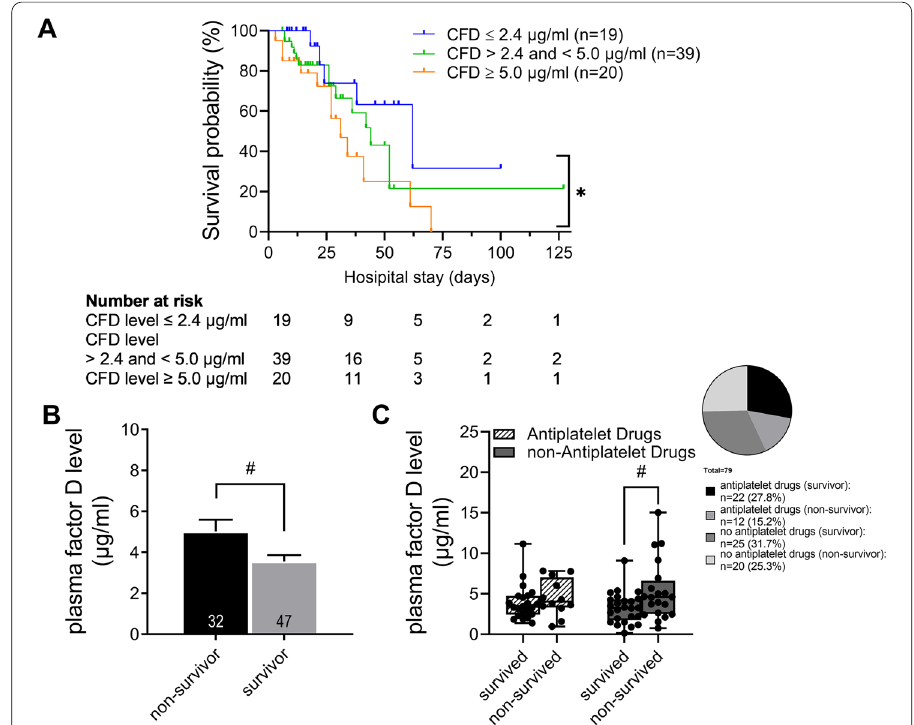
Fig. 2 Height of complement factor D level predicts disease severity. A Kaplan–Meier curve: cut-off values were estimated from 25th, 50th and 75th percentile. Complement factor D (CFD) levels above 75th percentile were associated with earlier and higher in-hospital mortality. B Complement factor D: highest mortality was associated with significant higher complement factor D level in non-survivors compared to survivor group. C Non-survivors with no antiplatelet drugs showed significantly higher CFD plasma level compared to patient who survived. Statistics: *statistical difference between indicated groups with p < 0.05. A Log-rank test. #Statistical significance ( p < 0.05) between non-survivor and survivors by means of B Student’s t -test or C Wilcoxon–Mann–Whitney. In total 79